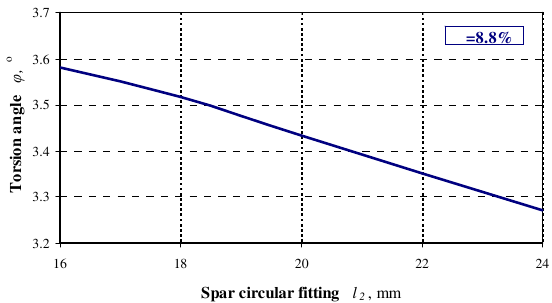
Fig 11. Influence of spar circular fitting on torsion angle